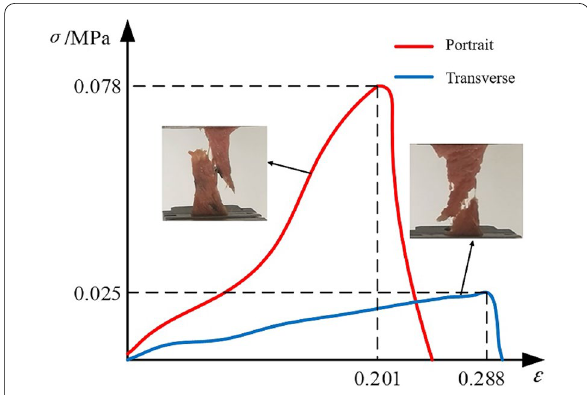
Figure 3 Strain-stress curve obtained by experiment data